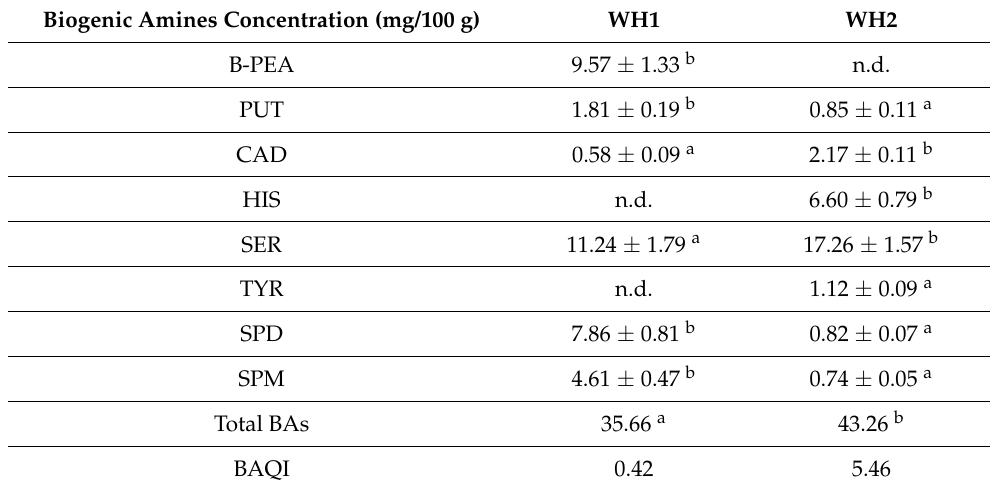
Table 3. Biogenic amines content in “Senatore Cappelli” durum wheat husks. Values are expressed as means (mg/100 g) ± standard deviation (SD) of three